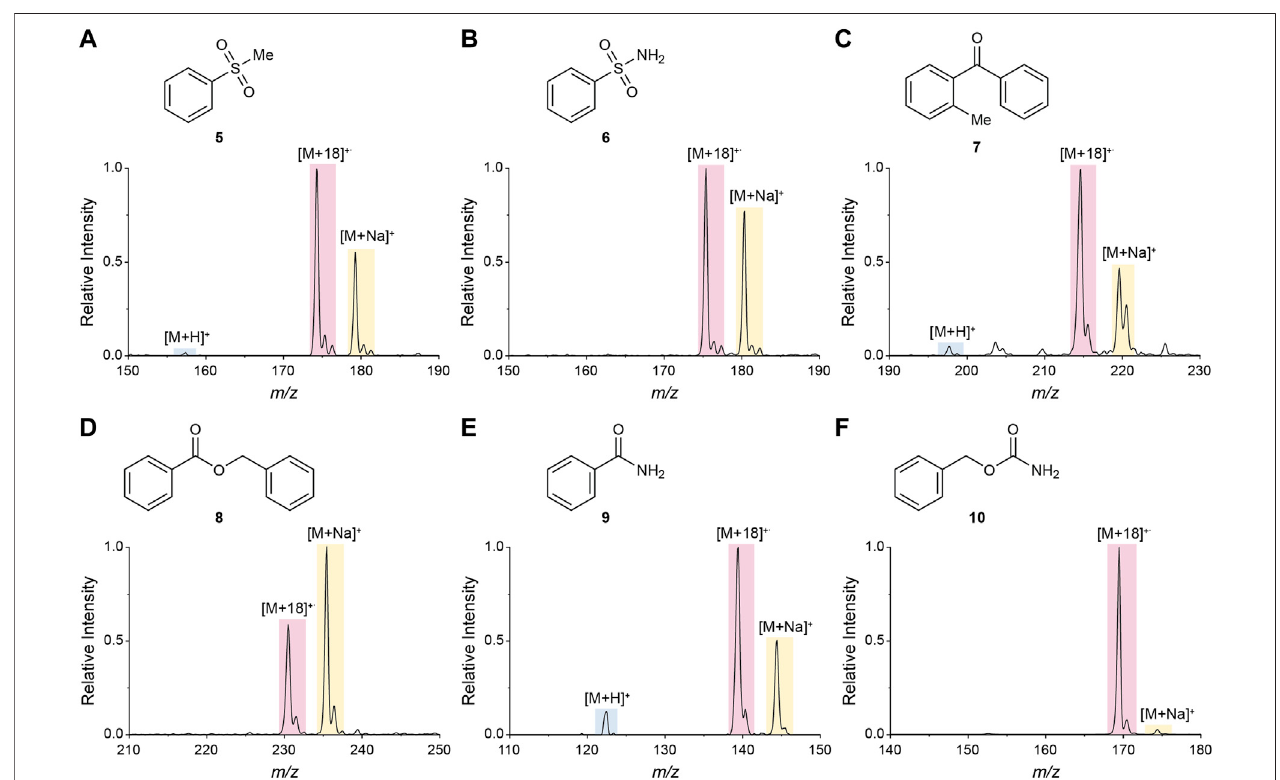
FIGURE 3 | Mass spectra of six monofunctional compounds in nESI-generated microdroplets. Sulfone (A) , sulfonamide (B) , ketone (C) , ester (D) , amide (E) , and carbamate (F) functionalities were explored.